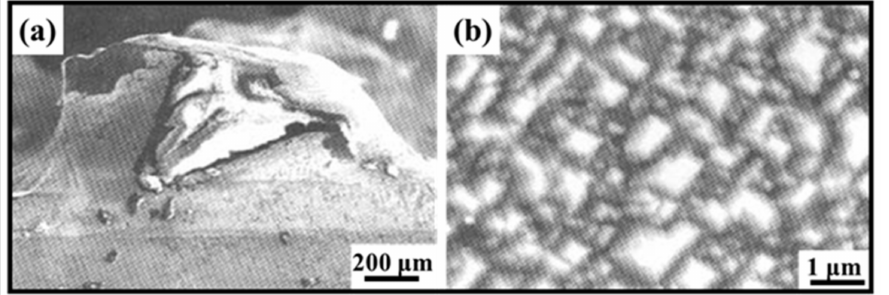
Figure 9. ( a ) Morphologies of diamond after brazing ( b ) Morphologies of carbide on diamond surface. Reprinted with permission from Ref. [54]. Copyright 2007, Transactions of the China Welding Institution.